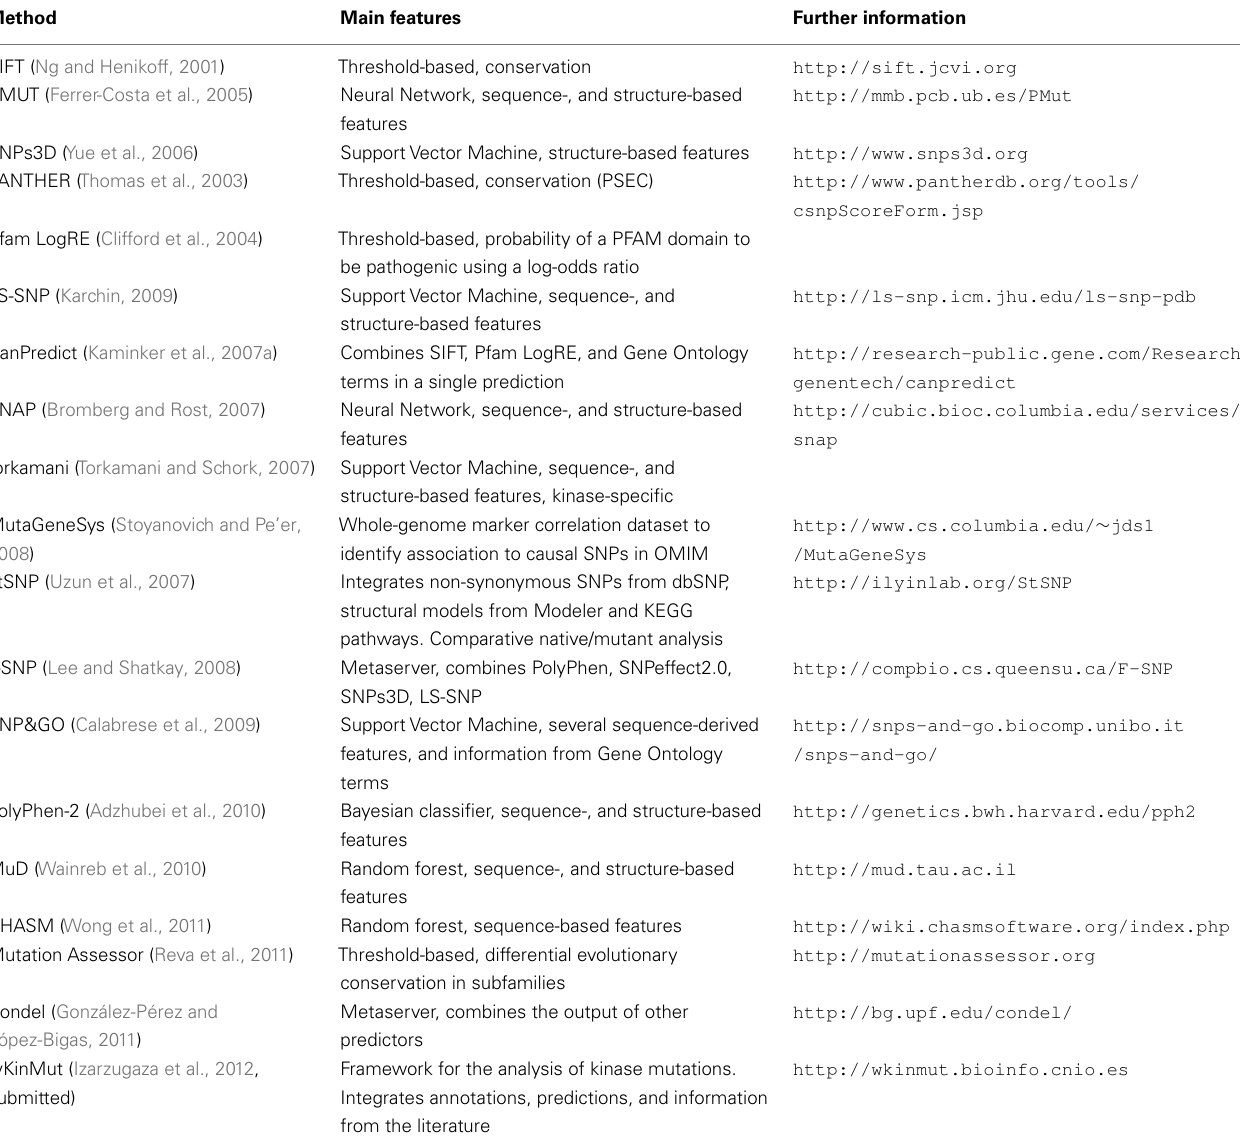
Table 1 | Summary of methods to predict the pathogenicity of